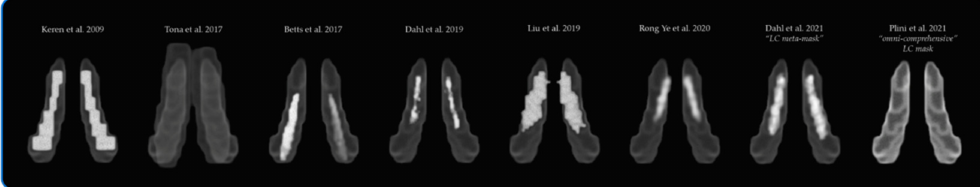
Figure 1. The spatial resolution of the new created symmetrical “omni-comprehensive” LC mask in comparison with the previously published LC MRI atlases and